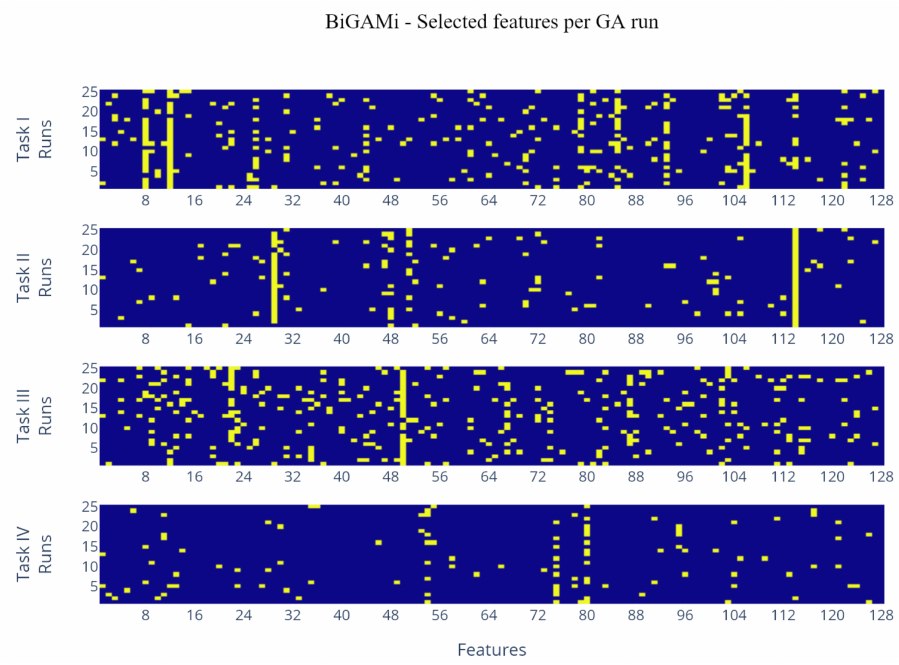
Figure 6. Feature selection heatmap per best performance data input. Runs represent the 25 BiGAMi runs per data input. Features represent the 128 features selected by the SelectKBest operation for each data input. Yellow marks indicate that a feature was part of the best performing GA individual feature subset. Vertical structures of yellow marks signal that a certain feature was consistently identified as being highly relevant across the 25 BiGAMi runs. Task I: Kostic colorectal cancer healthy/tumor GG97 CLR, Task II: Ravel vaginal Nugent category RefSeq CLR, Task III: Ravel vaginal black/white RefSeq Rel, Task IV: Qin cirrhosis RefSeq